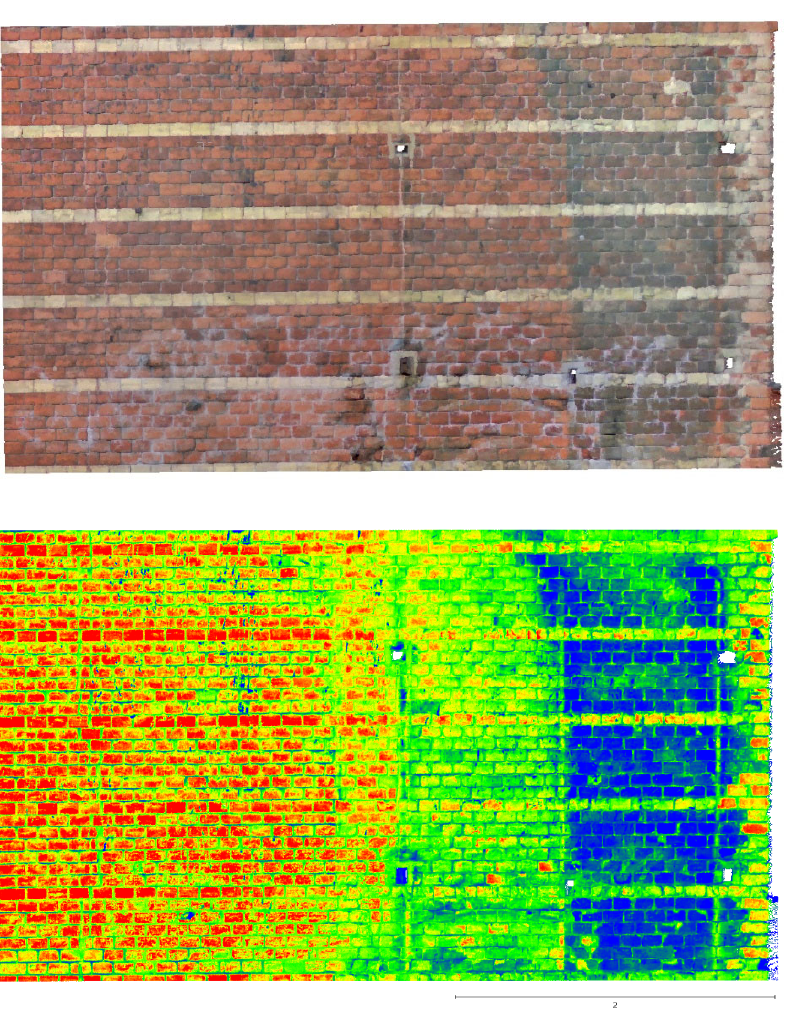
Figure 12. Detection of different types of bricks and places which are prone to saturation based on intensity value.